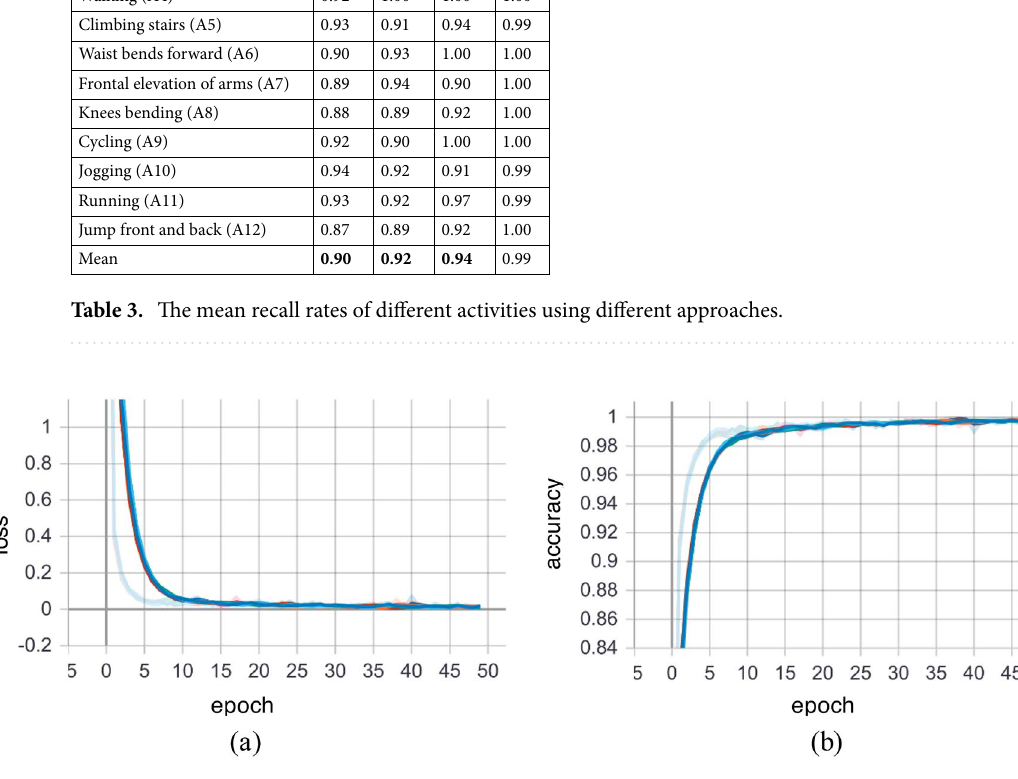
Figure 7. (a) Loss and (b) accuracy of the NSL model for 50 epochs and 10